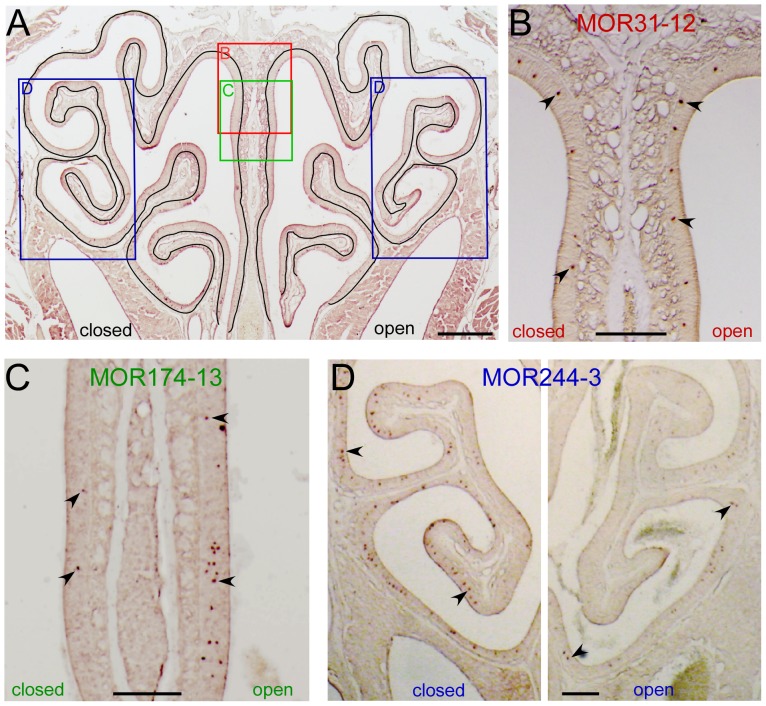
Unilateral naris closure differentially alters the cell density of individual OR genes.(A) The linear length from a coronal section was determined by outlining the basement membrane which separates the olfactory epithelium from the propria lamina. The rectangles indicate the approximate locations from which images in B–D were taken. (B–D) The coronal sections were hybridized with antisense RNA probes of MOR13-4 (dorsal zone, B), MOR174-13 (intermediate zone, C), and MOR244-3 (ventral zone, D). The two images in D were taken under identical conditions from the same section and the staining in the open side appeared much weaker than that in the closed side. Arrows mark examples of labeled cells. Scale bar = 0.5 mm in A and 0.2 mm in B–D.